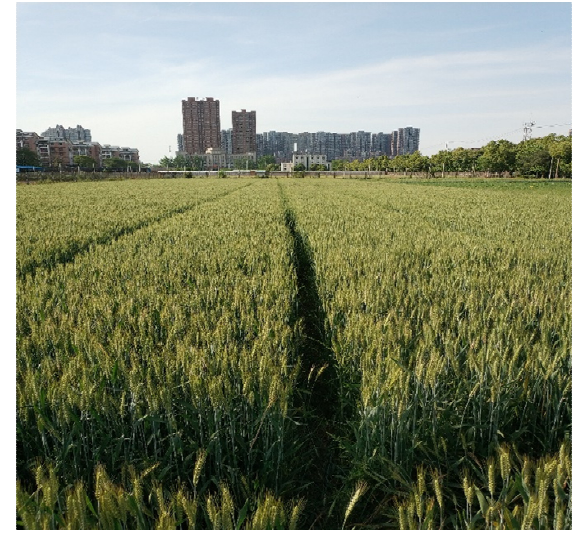
Figure 1. Experimental field plots